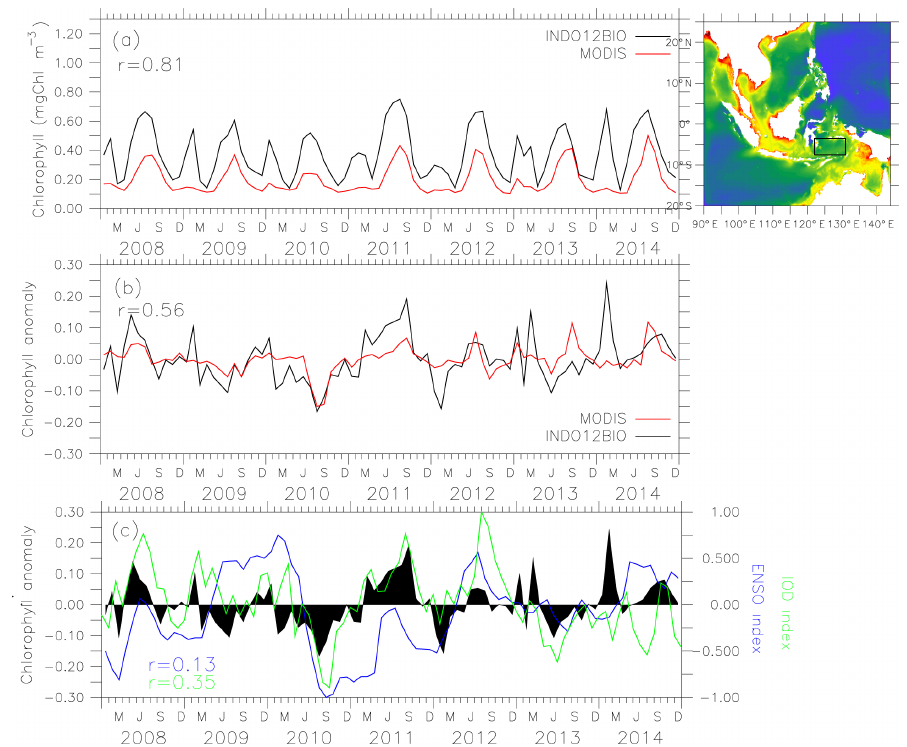
Figure 8. Same as Fig. 7, in the Banda